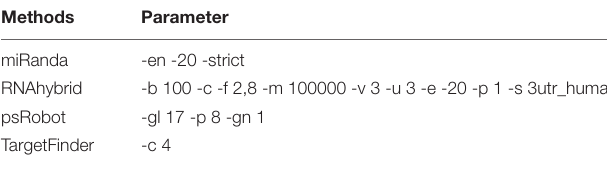
TABLE 2 | Default parameter for target